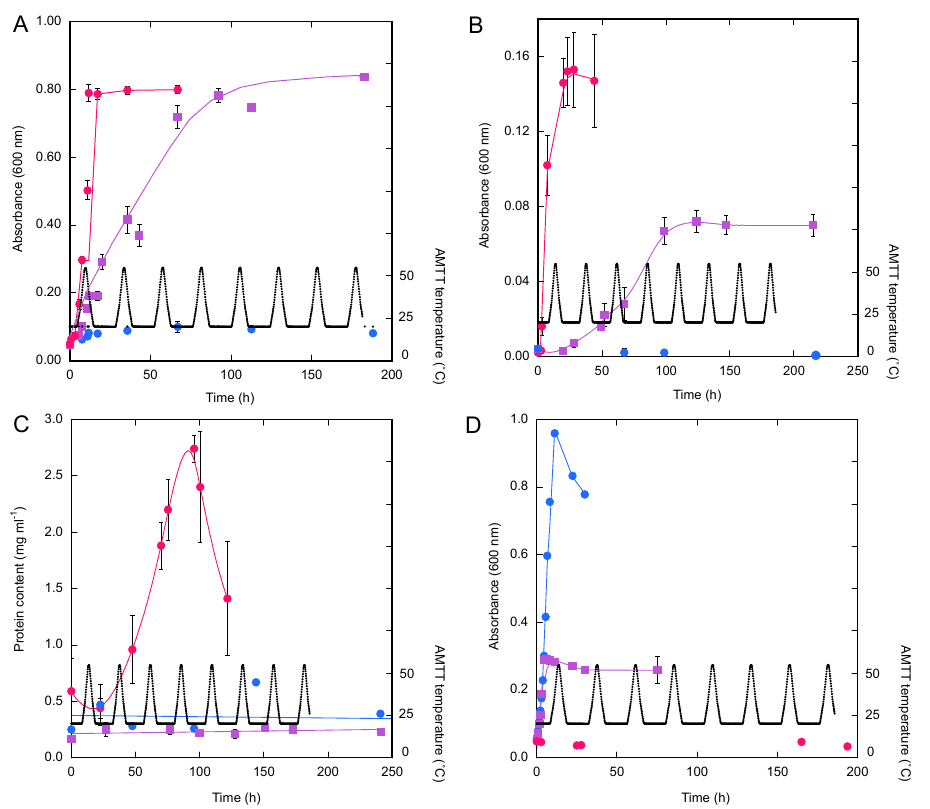
Figure 1. Growth (either A 600 or protein concentration) of Meiothermus ruber PS4 ( A ), Alicyclobacillus macrosporangiidus CPP55 ( B ), Thermogemmatispora carboxidovorans PM5 ( C ) and Paraburkholderia paradisi WA ( D ) at 55 °C (•), with the AMTT regime ( ■ ) or at 25 °C (•). AMTT temperatures are indicated in black. Data are means of triplicate determinations with ±1 standard error; some error bars are smaller than the symbols.